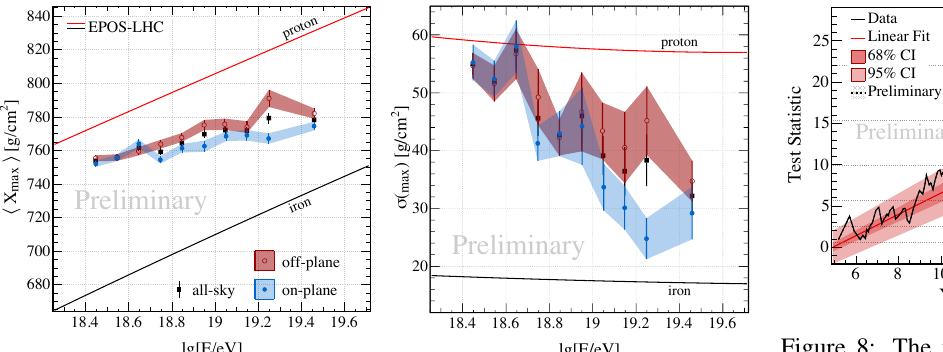
Figure 7: The first (left) and second (right) moments of the X max distributions from on- and o ↵ -plane regions.